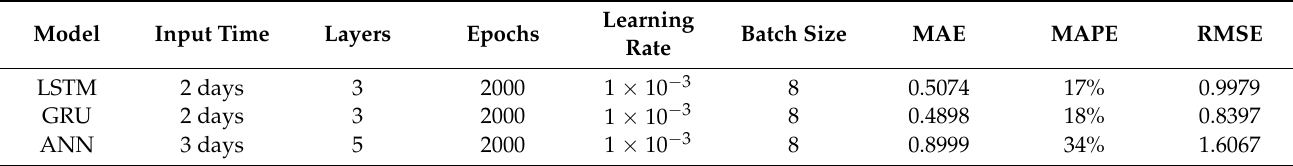
Table 5. The hyperparameter tuning results of CWB data.